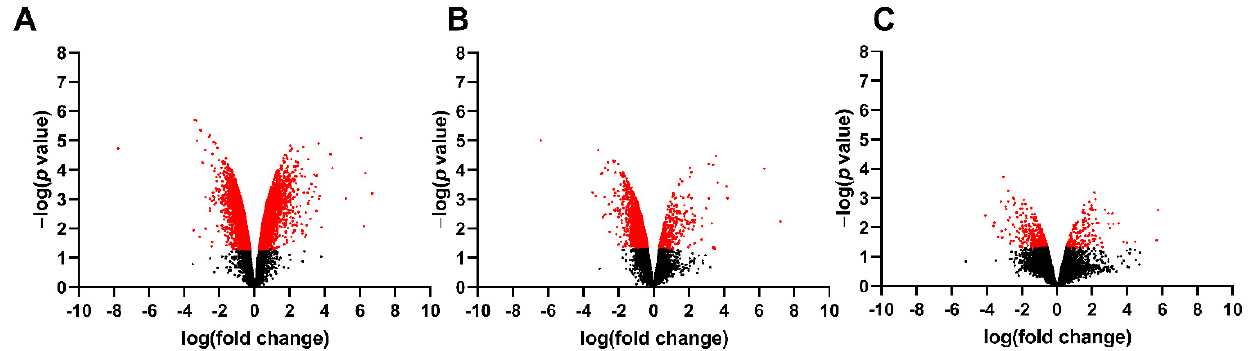
Figure 2. Volcano plot illustrating RNA-seq data of fetal spinal cords isolated from MMC and vehicle at ( A ) E15, ( B ) E17, and ( C ) E20. Red identifies genes that were greater than 1.5fold change and p < 0.05.